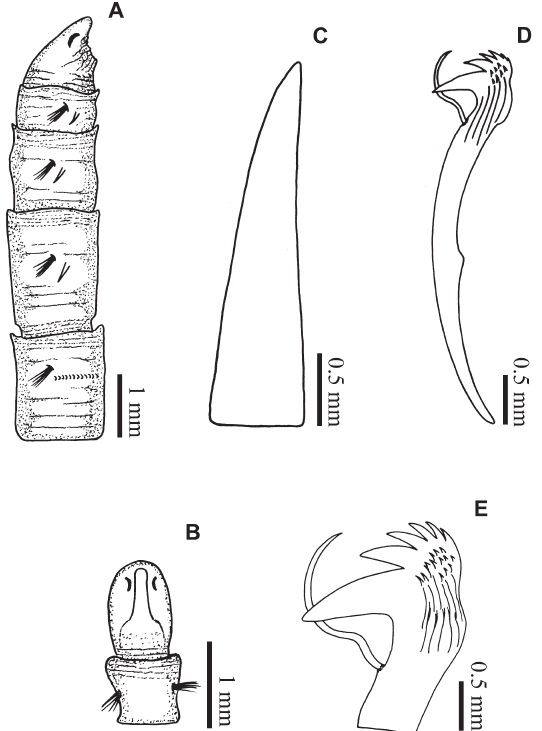
Fig . 4. – Petaloproctus vallejoi n. sp. A, anterior end of holotype, lat- eral view; b, head, dorsal view; C, acicular spine from setiger 1; D, rostrate uncinus from setiger 15; E, distal end of middle